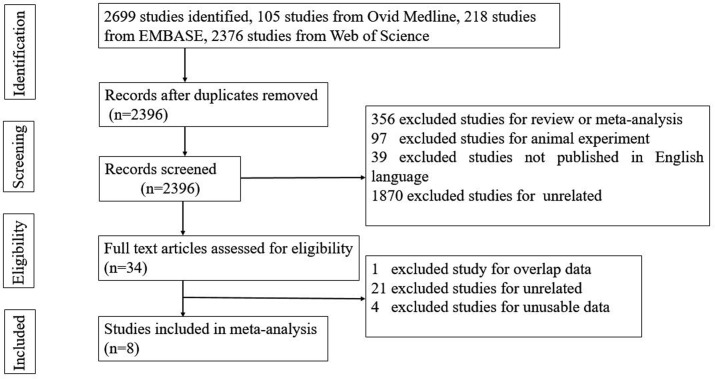
Flow chart for study selection.